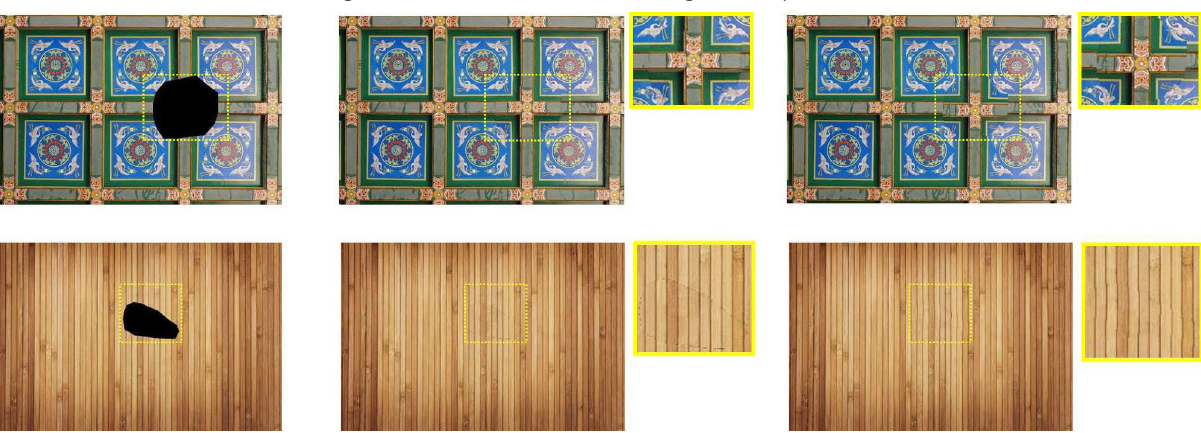
Figure 8. An illustration of the feathering area in a panorama.